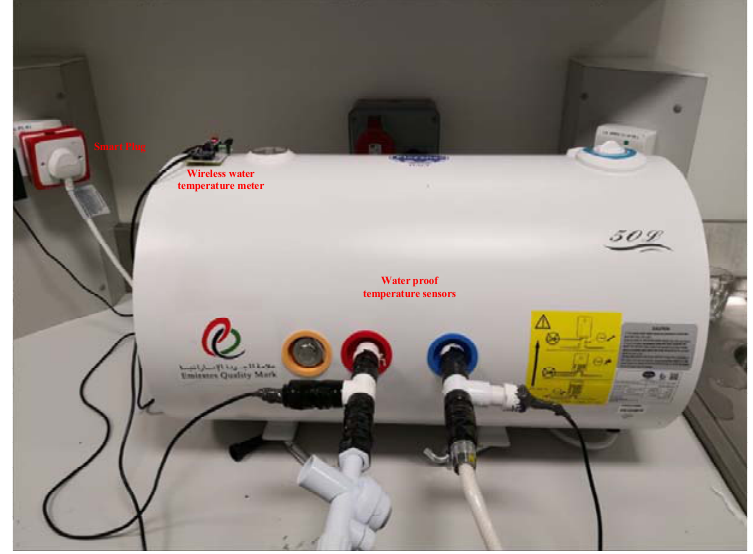
Figure 8. Experimental setup of the water heater.